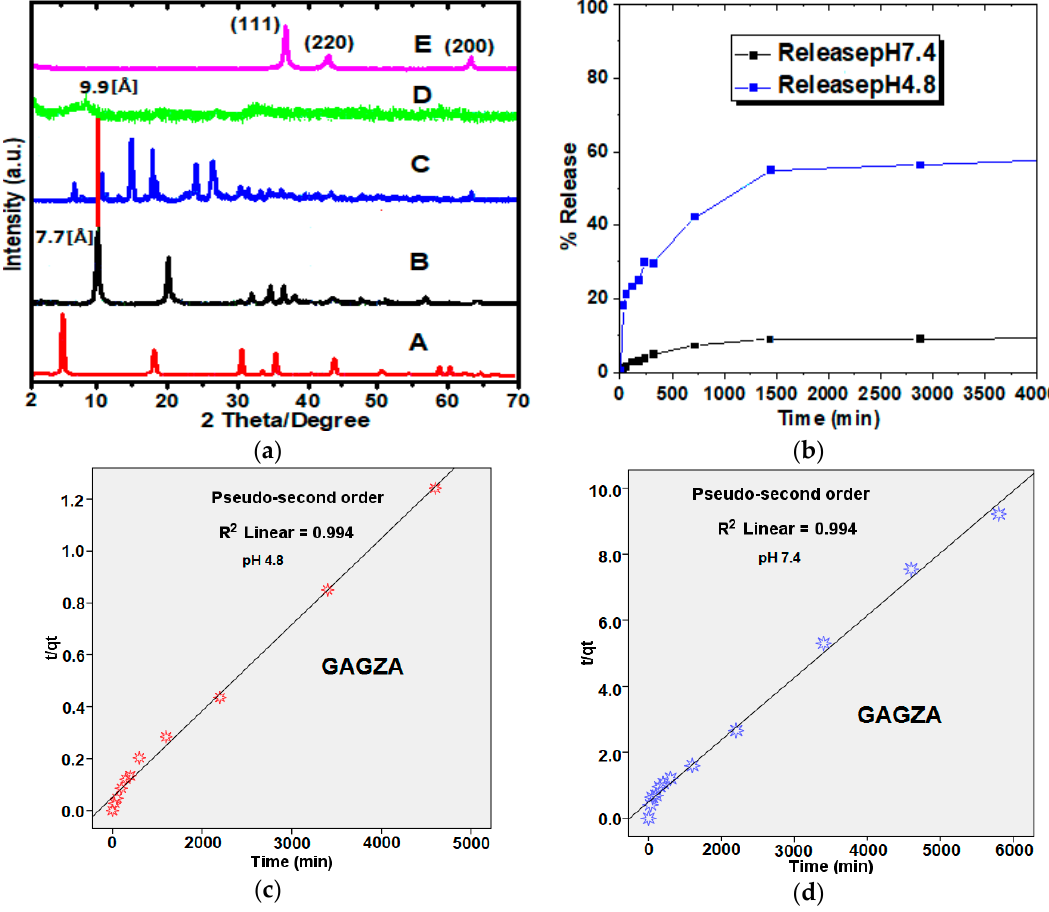
Figure 2. ( a ) X-ray diffractograms of (A) Gd(NO 3 ) 3 , (B) Zn/Al-LDH, (C) pure gallic acid, (D) gallic acid-Zn/Al-LDH-Gd nanocomposite (GAGZA), (E) gallic acid-Zn/Al-LDH/Gd-Au nanocomposite (GAGZAu); ( b ) Release profiles of gallic acid intercalated into Zn/Al-LDH-Gd nanoparticles (GAGZA) in phosphate-buffered solutions at pH 4.8 and pH 7.4; ( c ) Data of gallic acid released from GAGZA obtained at pH 4.8 fitted to pseudo-seconder order; ( d ) Data of gallic acid released from GAGZA obtained at 7.4 fitted to pseudo-seconder order.